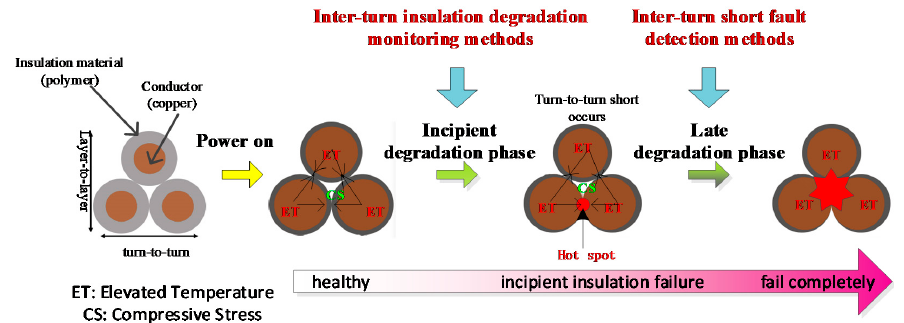
Figure 2. Incipient and late degradation phases of electromagnetic coils.